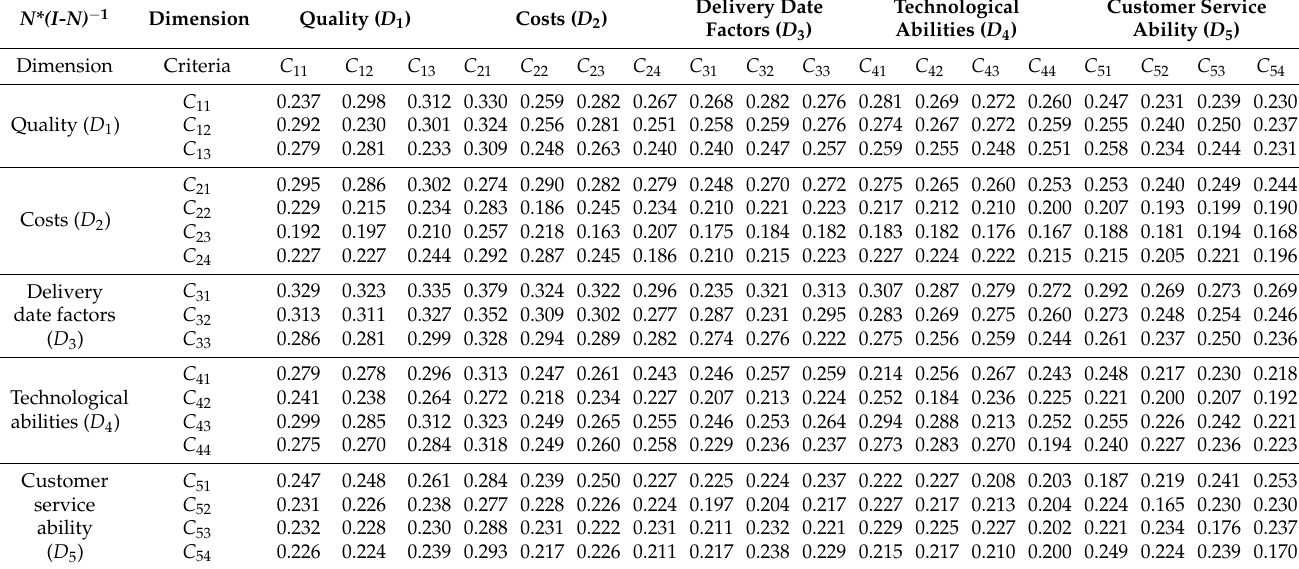
Table 6. Total influence matrix.